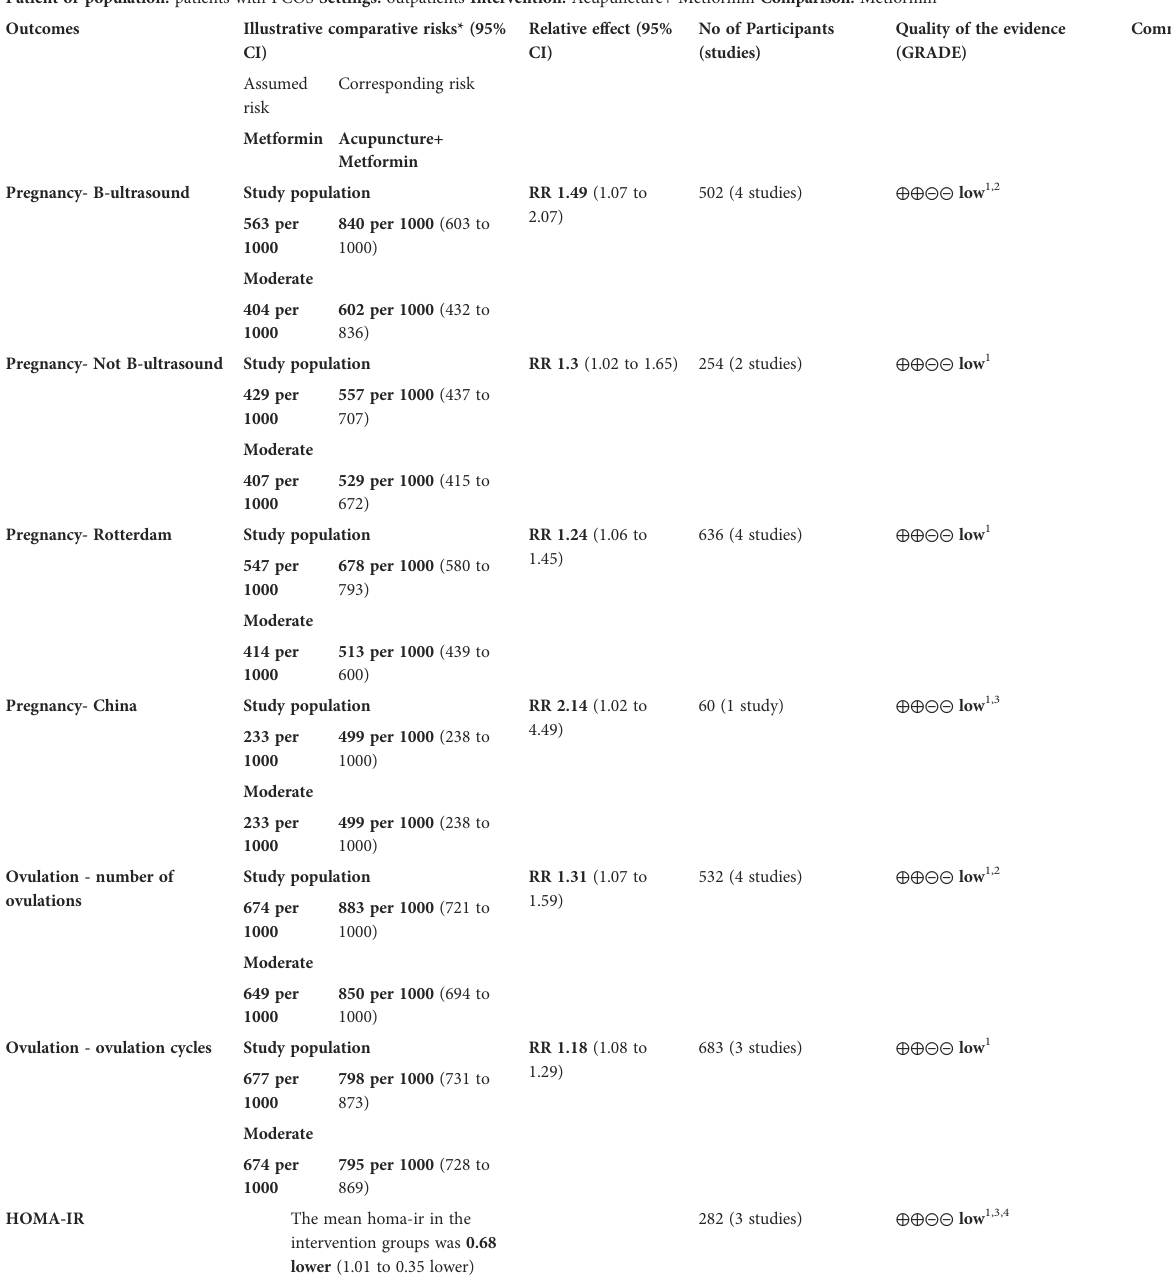
TABLE 2 Summary of fi ndings table. Acupuncture+ Metformin compared to Metformin for